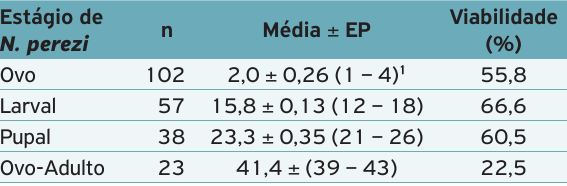
Tabela 2. Duração em dias (média ± erro padrão) das fases de